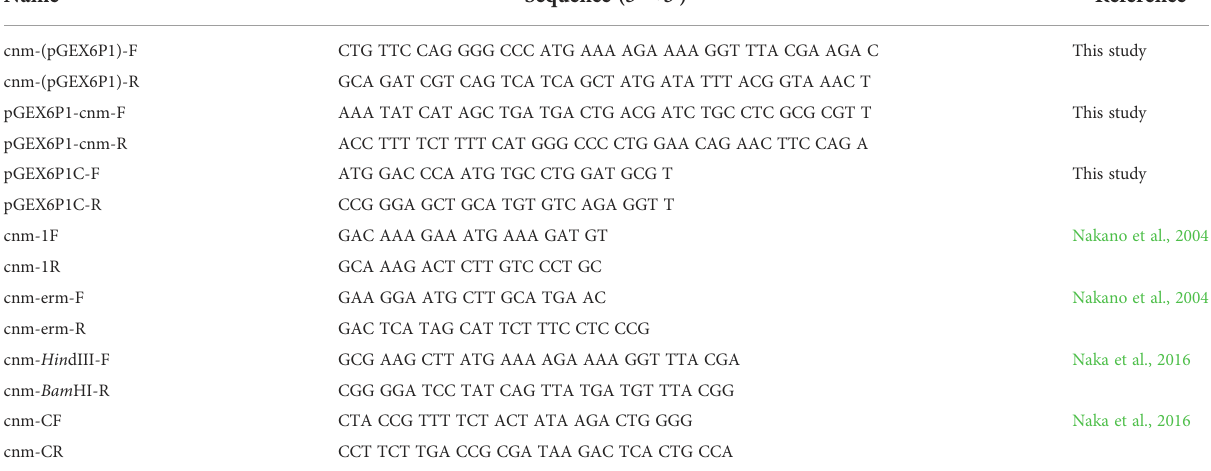
TABLE 1 PCR primers used in this